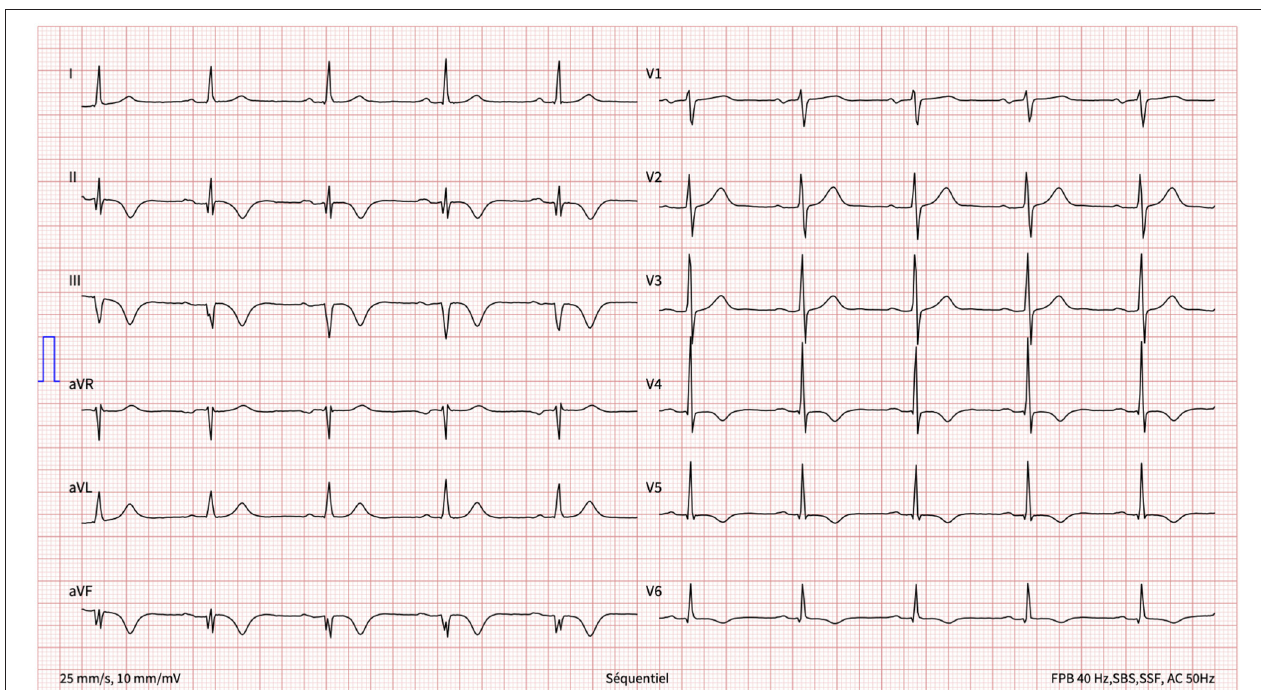
FIGURE 2 | 12-lead ECG on presentation to our hospital 1 week after the initial chest pain.